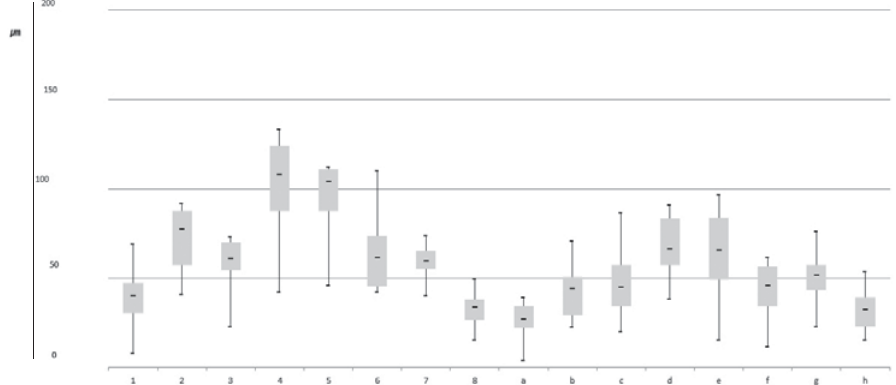
Figure 5- (cid:3)(cid:36)(cid:70)(cid:70)(cid:88)(cid:85)(cid:68)(cid:70)(cid:92)(cid:3)(cid:82)(cid:73)(cid:3)(cid:191)(cid:87)(cid:3)(cid:82)(cid:73)(cid:3)(cid:72)(cid:68)(cid:70)(cid:75)(cid:3)(cid:80)(cid:72)(cid:68)(cid:86)(cid:88)(cid:85)(cid:76)(cid:81)(cid:74)(cid:3)(cid:83)(cid:82)(cid:76)(cid:81)(cid:87)(cid:3)(cid:76)(cid:81)(cid:3)(cid:74)(cid:85)(cid:82)(cid:88)(cid:83)(cid:3)(cid:22)(cid:3)(cid:11)(cid:38)(cid:40)(cid:53)(cid:40)(cid:38)(cid:3)(cid:54)(cid:58)(cid:3)(cid:23)(cid:17)(cid:21)(cid:15)(cid:3)(cid:23)(cid:19)(cid:3) (cid:80) m). Uppermost point and lowermost point indicate the highest and lowest values of results. The top of box and bottom of box indicate the 75% and 25% values of results. The midline in the box means the average of the